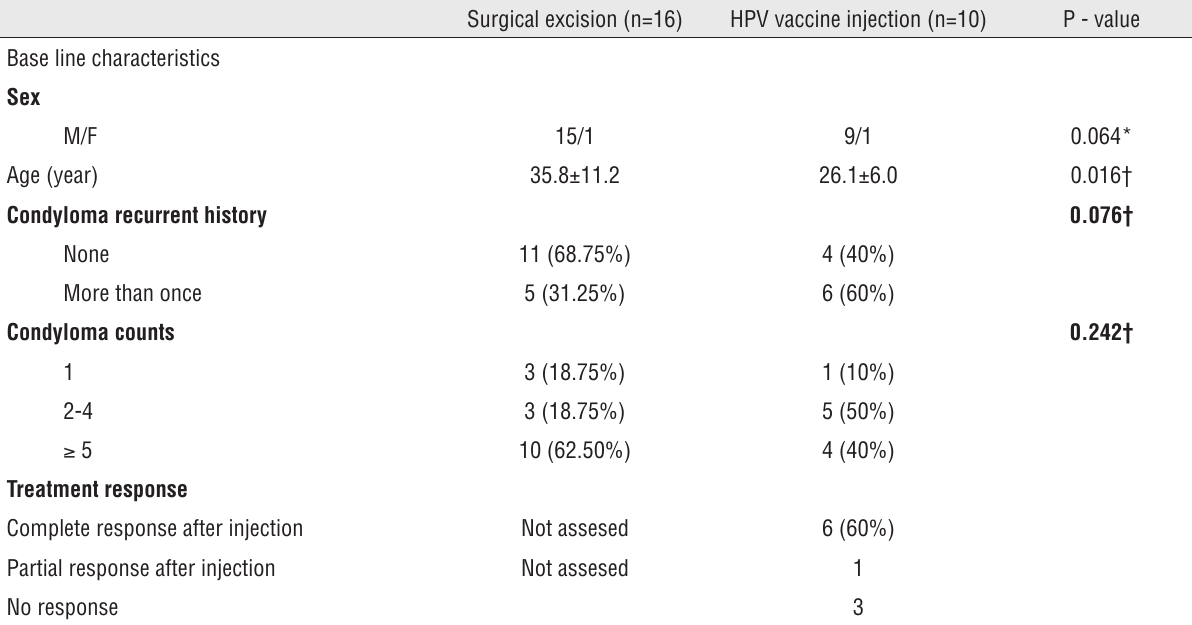
Table 1 - Treatment outcome in 26 HPv genital infection cases. Sixteen patients underwent surgical excision and 10 were administered